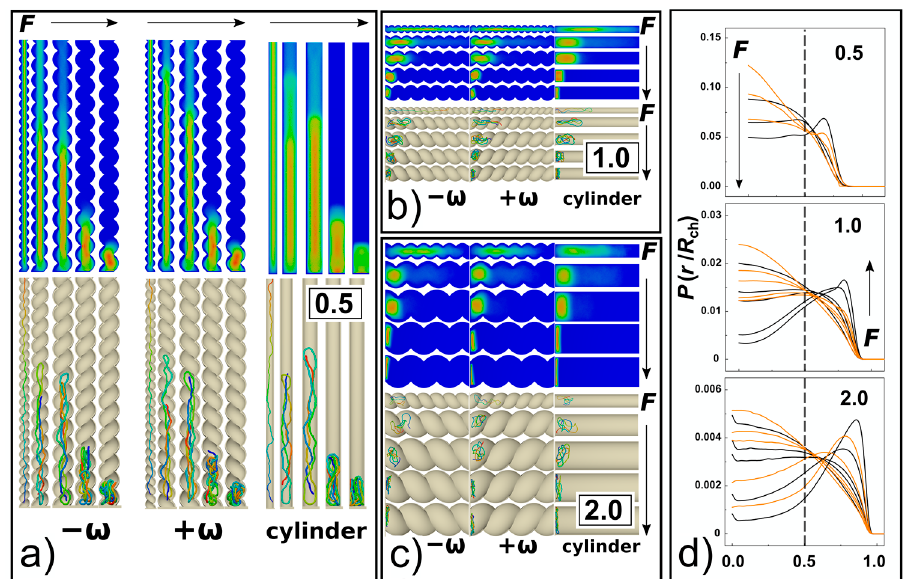
Figure 6. The compression of DNA in helical and cylindrical nano-channels. Panels ( a – c ) show planar projection heatmaps of distributions of DNA monomers across the channel together with snapshots for cylindrical channels and helical channels with negative and positive handedness. F ’s with the arrows indicate the direction of increasing force ( F σ / ε 0 = 0.1, 0.5, 1, 5, 20); ( d ) the panel shows the radial distribution function of the DNA monomers along the radial coordinate of the channel, for D / P = 0.5 shown with three lines F σ / ε 0 = 0.1, 1 and 20; and F σ / ε 0 = 0.1, 0.5, 1, 5, 20 for D / P ≥ 1.